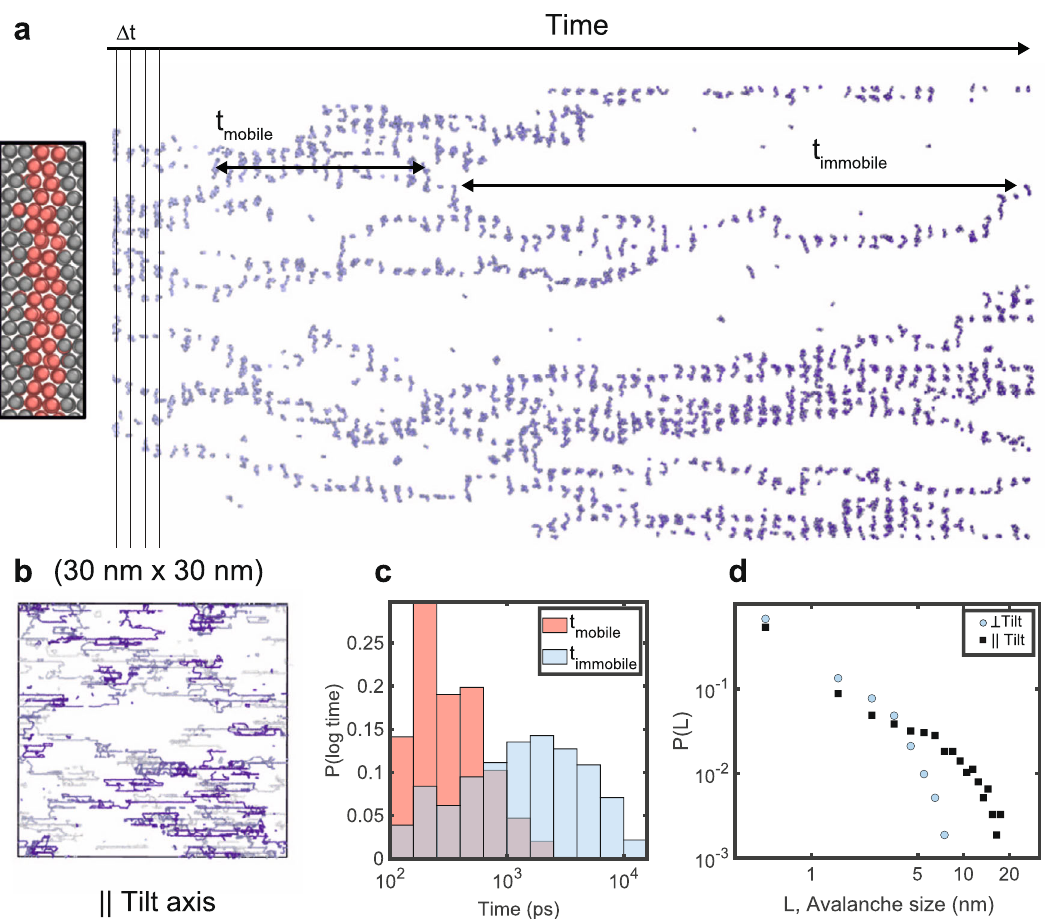
Fig. 5 Avalanche time and length scales. a Space-time atomic mobility diagram for the Σ 3 GB at 700 K computed with the time interval of Δ t = 40 ps and viewed perpendicular to the tilt axis. The fi nite temperature GB structure is shown on the left with light grey FCC atoms and red non-FCC atoms. The immobile clusters are evident as voids (or bubbles) 24 separating mobile atom trajectories. The arrows show examples of mobile and immobile cluster dimensions in time. b Cross section of the same diagram with all time data projected onto the GB plane. The rectangular box indicates the 6 nm scale of the GB structure shown in ( a ) relative to the GB area. c Probability distribution of lifetimes of mobile and immobile clusters. Note that immobile clusters persist on a longer time scale than mobile clusters. d Avalanche size distribution at 720 K as measured by the maximum avalanche size perpendicular and parallel to the tilt axis. The avalanches are elongated along the tilt axis and exhibit a cutoff behavior with large avalanches becoming increasingly unlikely with increasing size. Note that the cutoff size along the tilt axis is larger than 10